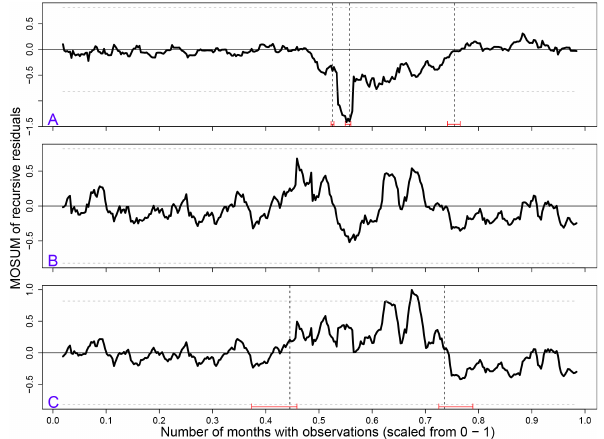
Fig. 4. Plots of MOSUM for the linear relationship (A) between wa- tersheds, (B) between monthly flow and monthly rainfall in WS77, and (C) between monthly flow and monthly rainfall in WS80. A shift of the MOSUM outside the 95% confidence intervals (hor- izontal dashed grey lines) indicates a structural break in the lin- ear relationship. The vertical dotted lines in (A) and (C) are esti- mated breakpoints (break dates). The corresponding red horizontal lines that cross each break date are the respective 95% confidence intervals for each break date. Because the analysis is on moving sums, the location where the MOSUM crosses the 95% confidence boundary is not always the location of the breakpoints. Also, when the MOSUM returns within the 95% confidence boundary, it does not mean the relationship has regained structural stability. There are three break dates in (A) corresponding to March 1993, March 1994, and April 2004. The first break date in (C) corresponds to June 1990 while the second break date corresponds to April